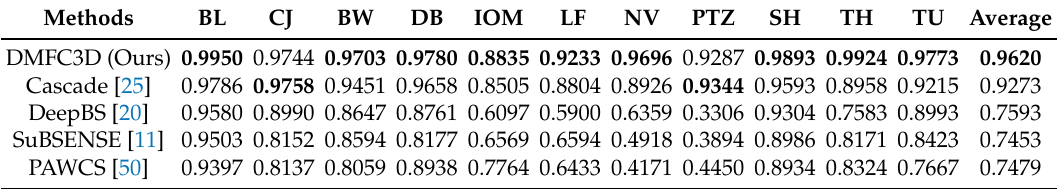
Table 1. FM metric comparison of different foreground detection methods over all categories of the CDnet2014: baseline (BL), cameraJitter (CJ), badWeather (BW), dynamicBackgournd (DB), intermittentObjectMotion (IOM), lowFramerate (LF), nightVideo (NV), PTZ, shadow (SH), thermal (TH), and turbulence (TU).